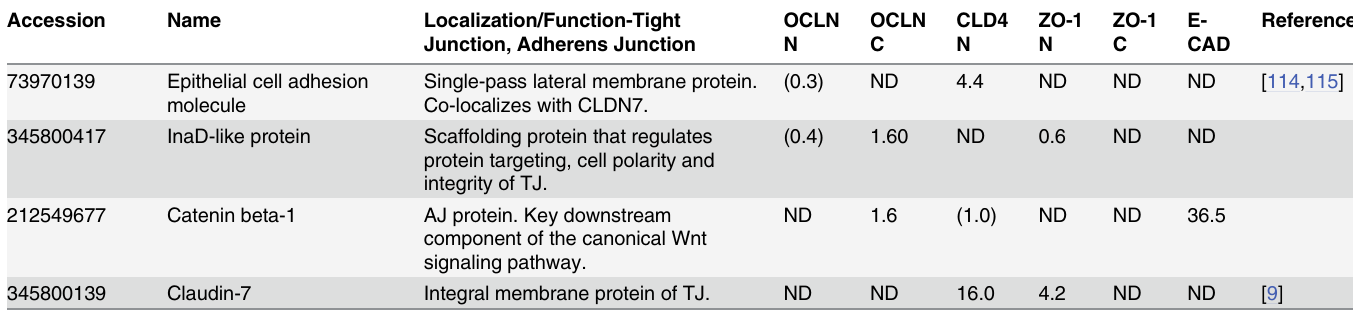
ZO-1 which is focused at the TJ, both claudins and Ocln also show variable localization to the lat- eral membrane [6,7,12,19,20,33,38,40]. As integral membrane proteins they are also expected to be near proteins in biosynthetic vesicular trafficking pathways [2,25,26,41 – 47]. As expected, en face immunofluorescent images of the TJ protein ZO-1 (Fig. 1A, left panels) and BL-Ocln, Ocln- BL and BL-Cldn4 fusion proteins (middle panels) reveals colocalization at TJs (right panels), as reported by myc epitope staining. The biotin ligase fusion proteins are also found to a variable extent in intracellular compartments. In contrast, we have previously shown that myc-tagged bi- otin ligase alone is diffusely distributed throughout the cells including the nucleus